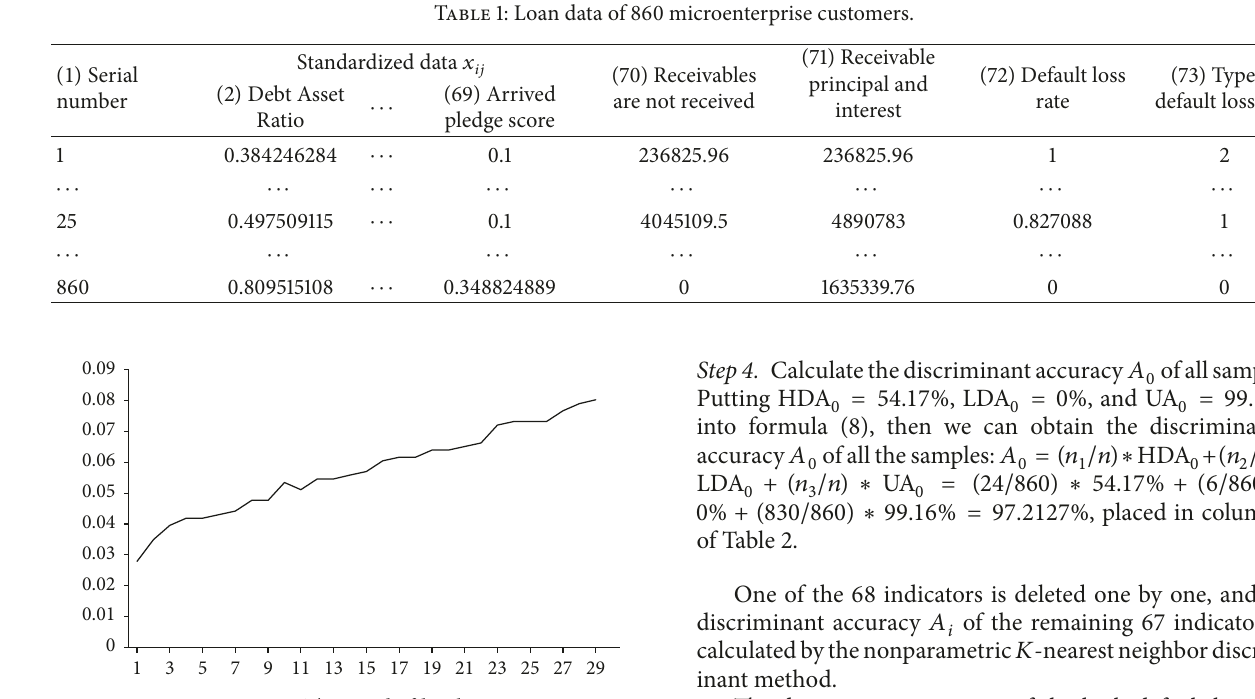
Figure 1: The trend of 𝑘